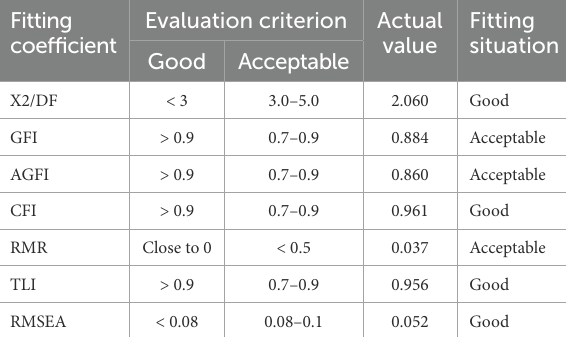
TABLE 4 Model fitness parameters.